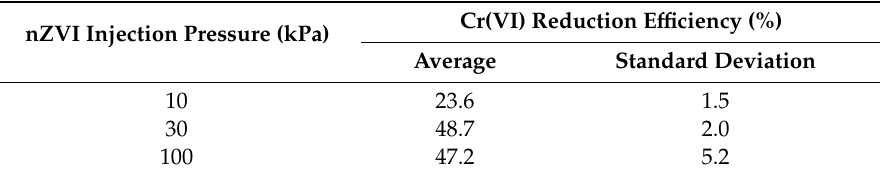
Table 2. Soil contaminant reduction e ffi ciency with di ff erent pressures